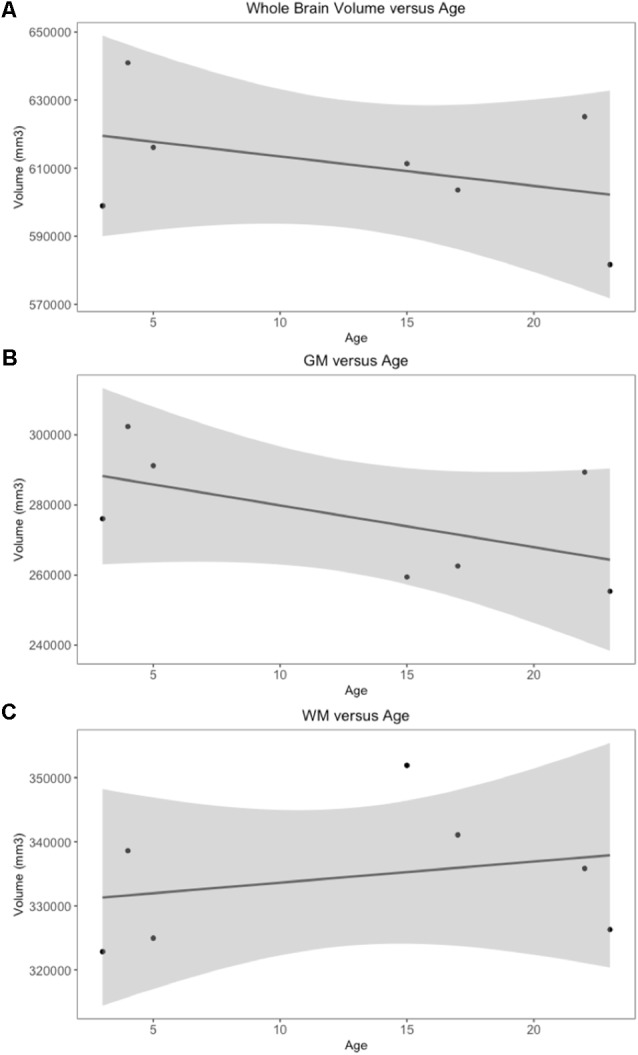
Scatter plots of individual subject whole brain, gray matter (GM) and white matter (WM) volumes plotted against age. Only subjects with a definitive age (subject 1, 3, 4, 5, 7, 8 and 9) were included in this analysis). (A) Whole brain volume vs. age demonstrates a downward trend in volume as age increases. (B) GM vs. age demonstrates a downward trend in volume as age increases. (C) WM vs. age demonstrates an upward trend in volume as age increases.